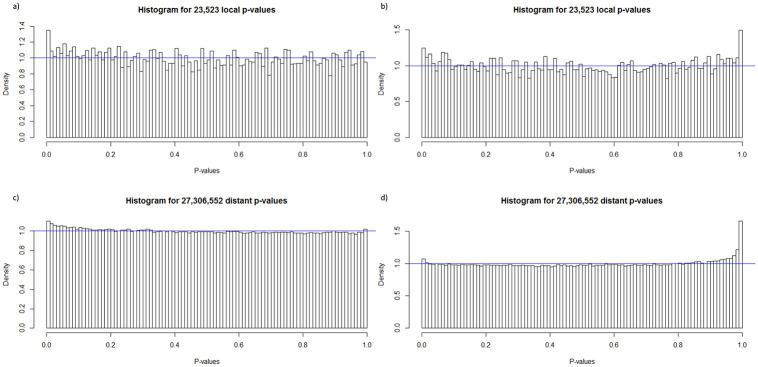
Histograms of the p-value distributions.Histograms of the p-value distributions of all cis (a,b) and trans(c,d) eQTL pairs in the linear(a,c) and ANOVA(b,d) models. Based on the overall distribution, we see a slight anti-conservative trend in the linear p-values in both cis and trans-eQTLs.